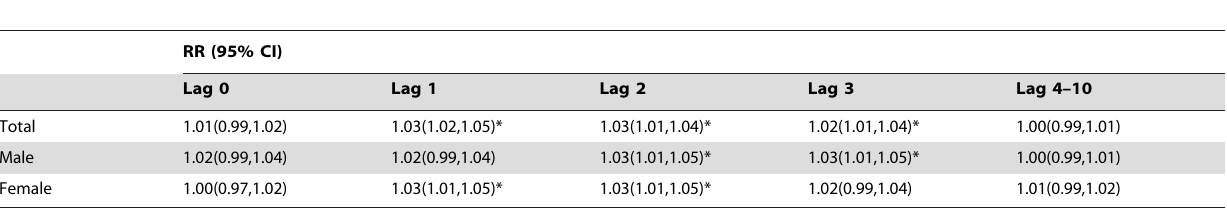
Table 2. Relative risk (RR) of diarrhea in children under five years associated with one unit increase in diurnal temperature